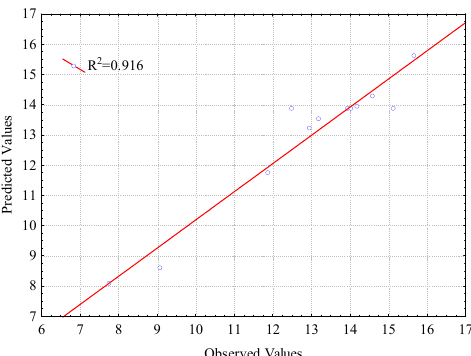
Figure 3. Prediction of R 2 in the experimental data and the data predicted by the model, using response surface methodology (RSM).